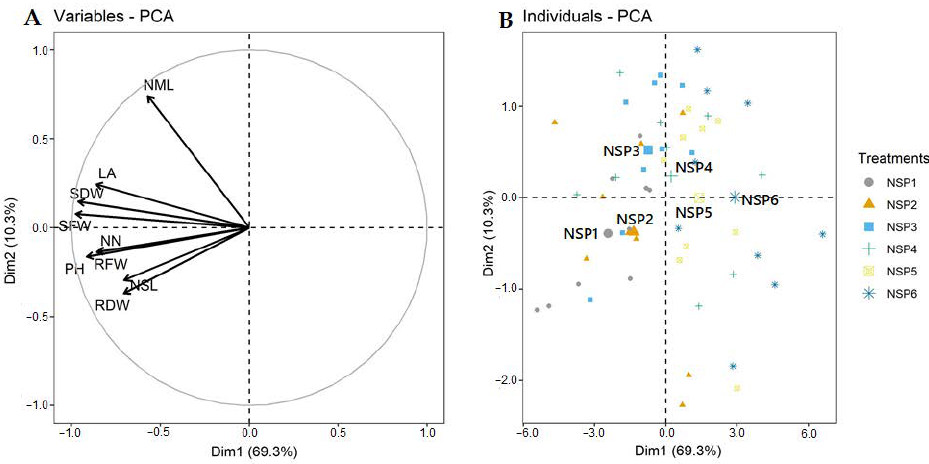
Figure 4. Principal component analysis (PCA) showing the effects of EC levels (1–6 dS m − 1 ) of newly-developed nutrient solution for red perilla (NSP) on the plant growth characteristics. ( A ): the correlation circle of variables (SFW: shoot fresh weight, SDW: shoot dry weight, RFW: root fresh weight, RDW: root dry weight, PH: plant height, NN: number of nodes, NML: number of main leaves, NSL: number of side leaves, LA: leaf area); ( B ): the scatter plot of individuals (EC levels of NSP 1–6 dS m − 1